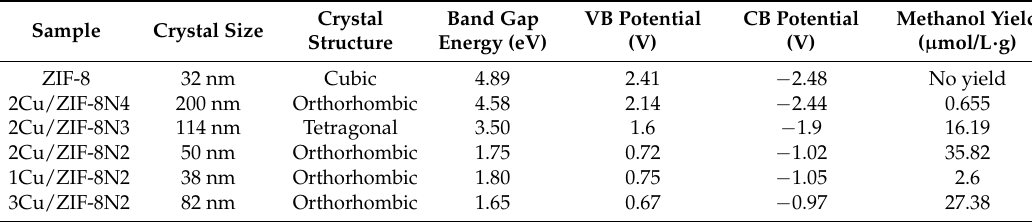
Figure A1. Reactor setup attached with intensity meter. Table A1. Summarized data of all catalyst synthesized in this study.